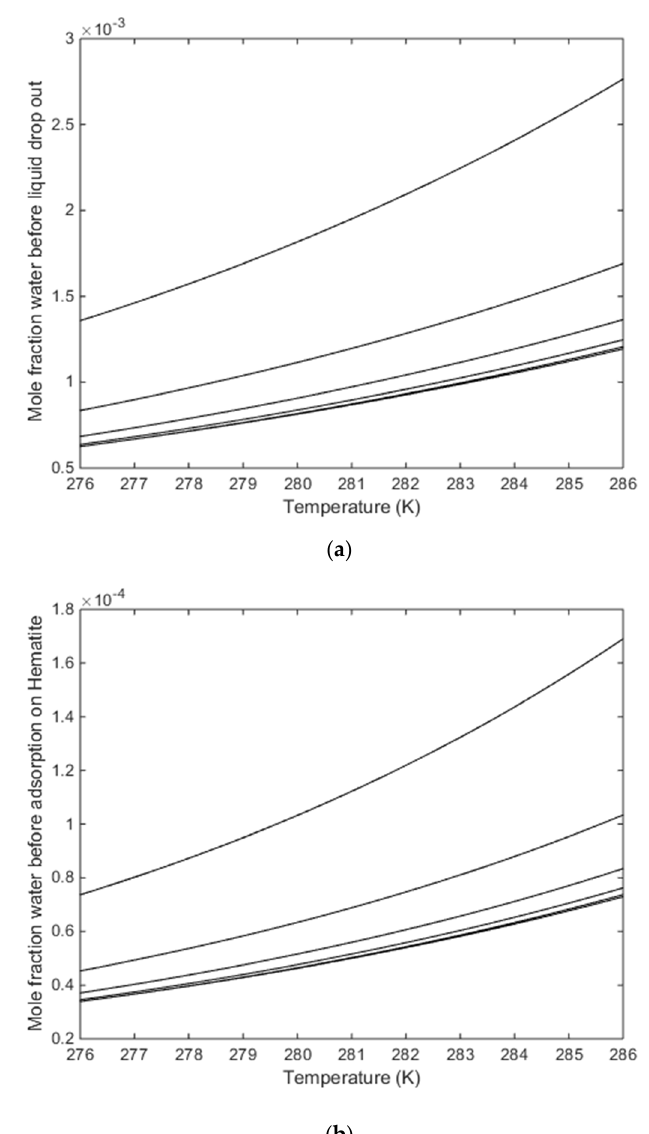
Figure 5. ( a ) Calculated water dew-point mole-fractions from a gas containing 90 mole per cent CH 4 and the rest CO 2 . ( b ) Calculated water mole-fraction for water in gas containing 90 mole per cent CH 4 and the rest CO 2 before adsorption onto hematite.